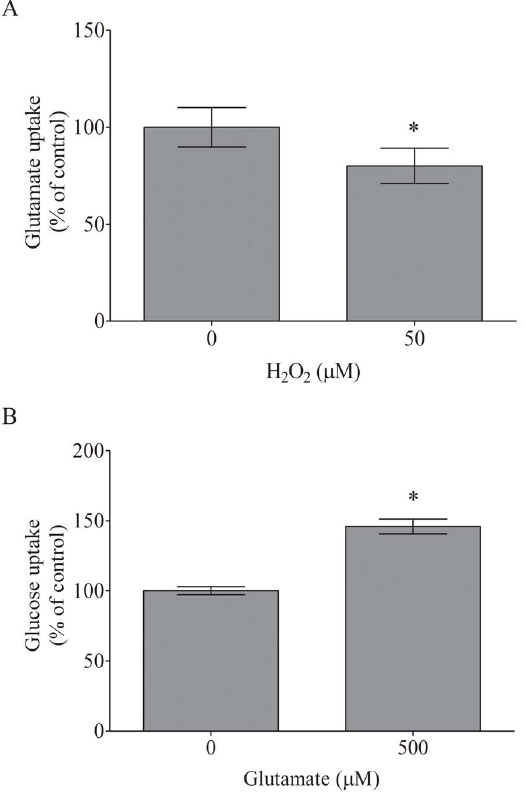
Figure 6. Adult astrocytes take up glutamate (A) and glucose (B). To determine the glutamate uptake, the culture medium was removed followed by the addition of DMEM/F12 supplemented with 5% FBS in the presence or absence 50 m M H 2 O 2 for 3 h. To determine the glucose uptake, the medium was then replaced by DMEM/F12 supplemented with 1% FBS containing 1 m Ci/ml [ 3 H]2DG, in the presence or absence of 500 m M glutamate for 20 min. In all procedures, the cells were maintained at 5% CO 2 /37 u C. The assays were performed as described in the Materials and Methods section. Absolute values obtained under control conditions were 0.8 6 0.08 nmol/mg protein/ min for glutamate uptake and 172 6 20 fmol/mg protein for glucose uptake. The data represent the mean 6 S.E. from 4 to 6 experimental determinations performed in triplicate. * P , 0.05 indicates significant differences from the control values. respectively (Fig. 7). Next, the effect of resveratrol against H 2 O 2 - resveratrol for 1 h prior to the H 2 O 2 exposure (50 m M for 3 h) was